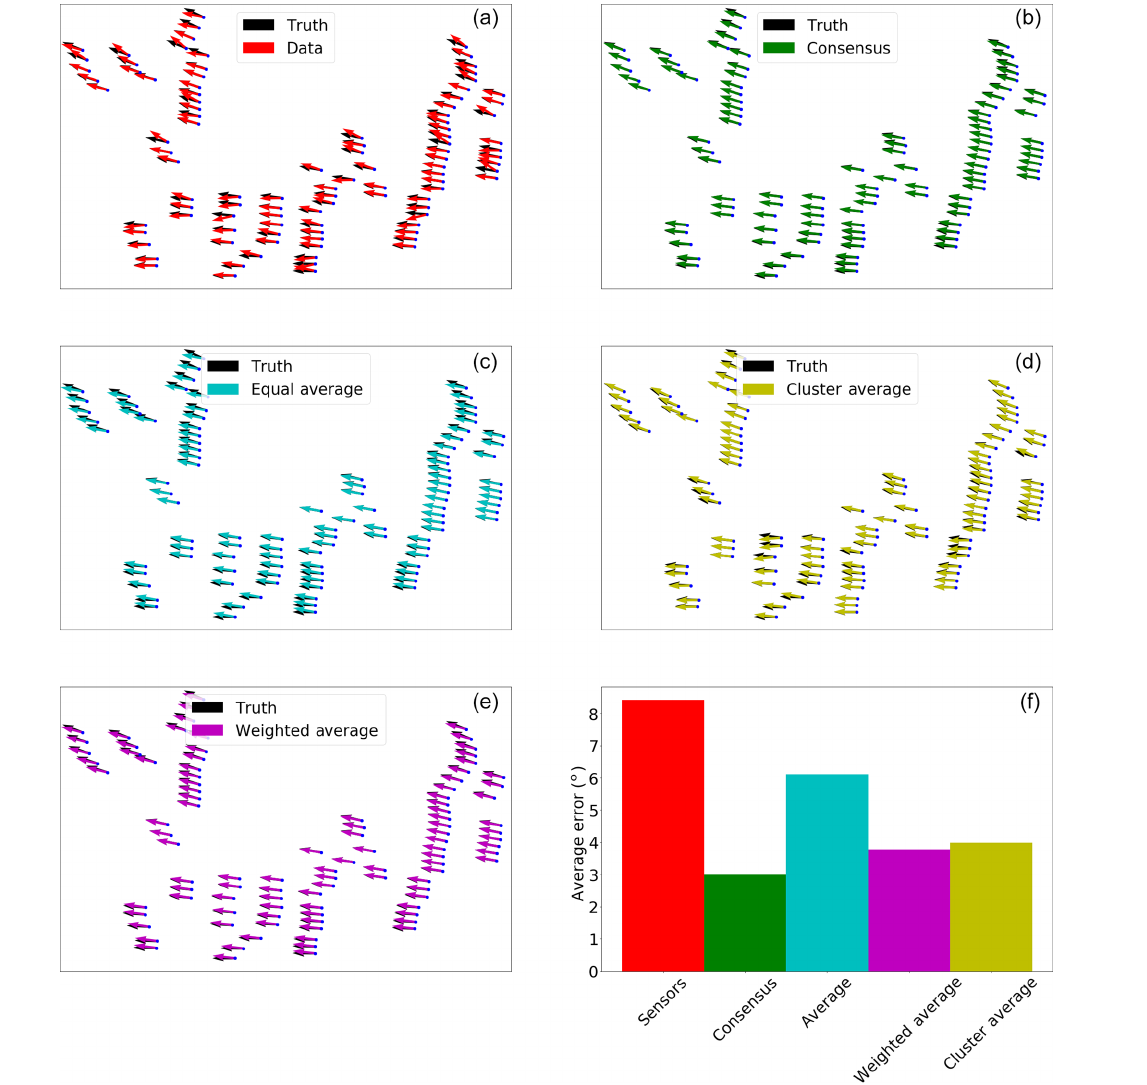
Figure 6. This figure demonstrates the performance of the different methods on a larger wind farm than the one shown in Fig. 2 with noisy signals and a wind direction change across the wind farm. Panel (a) shows the “true” data and the actual data. Panel (b) shows the results of the consensus algorithm. Panel (c) shows the results of implementing equal averaging across the wind farm. Panel (d) shows the cluster averaging approach and (e) shows the weighted averaging approach across the full wind farm. The mean absolute errors of each of the methods are shown in panel (f)